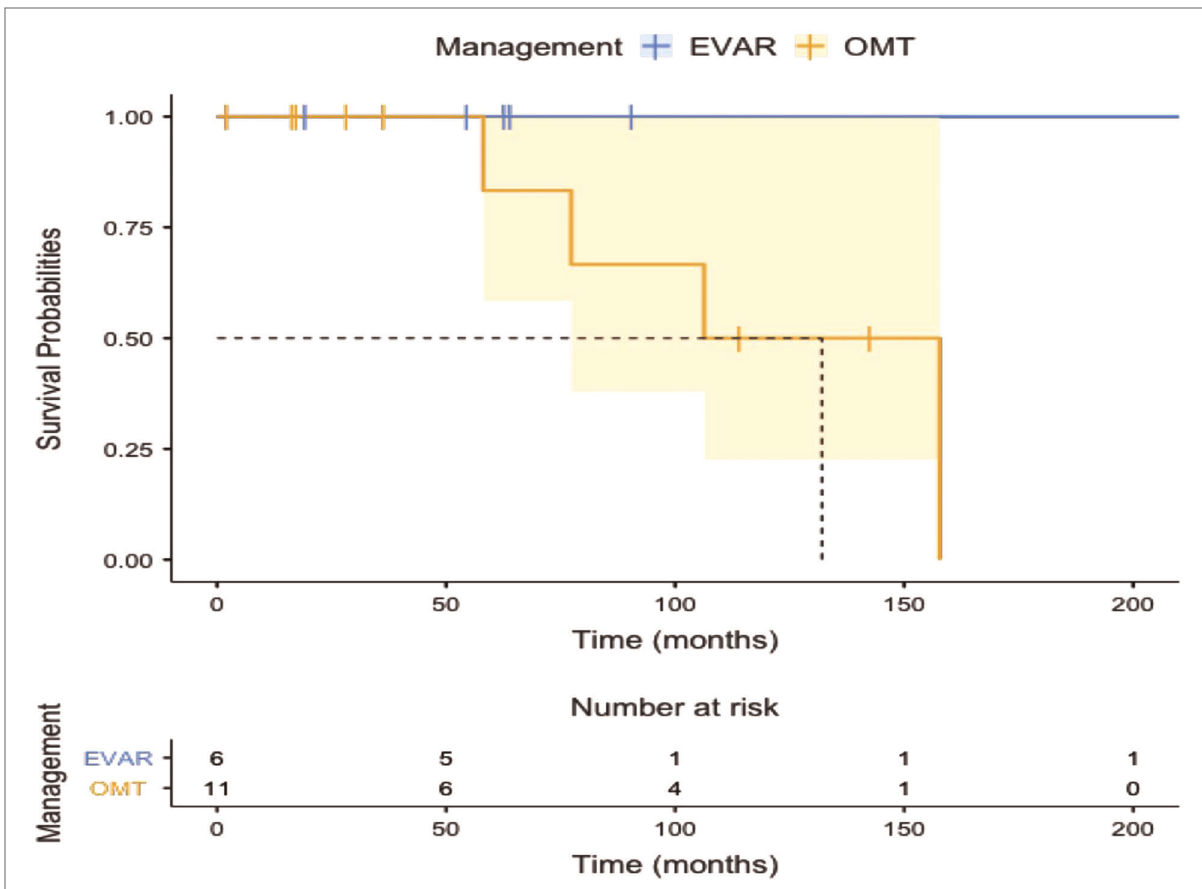
FIGURE 5 Kaplan-Meier plot showing symptom-free survival in patients with optimal medical therapy (OMT) and endovascular aneurysm repair